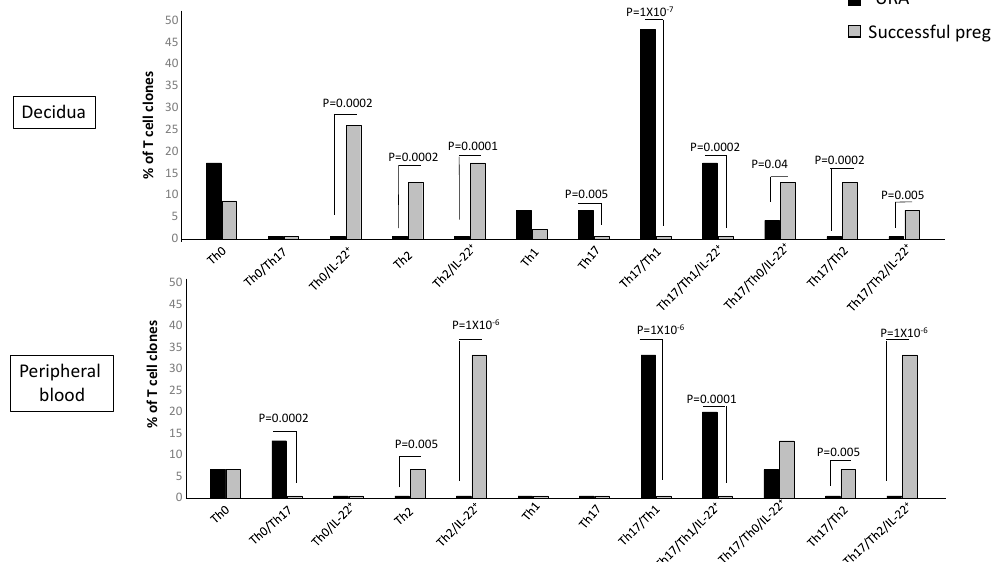
Figure 5. T helper subpopulations present in the decidua and in the peripheral blood of those T helper subpopulations present in the decidua and in the peripheral blood of experiencing unexplained recurrent abortion and those experiencing successful pregnancy. To those experiencing unexplained recurrent abortion and those experiencing successful investigate the CD4+ cell subsets that produce IL-22, the percentages of Th1-, Th2-, Th0-, Th17-, Th17/Th1-, Th17/Th2-, and Th17/Th0 cells, which do not produce IL-22 and which also produce IL-22 (Th1/IL-22+, Th2/IL-22+, Th0/IL-22+, Th17/IL-22+, Th17/Th1/IL-22+, Th17/Th2/IL-22+, and Th17/Th0/IL-22+) were analyzed. Cytokines were measured in the supernatants of the CD4+ T cell clones derived from the decidua and peripheral blood of those experiencing successful pregnancy and those experiencing unexplained recurrent abortion (URA) (Experiment 1 in section 4.3) by a multiplex bead-based assay. The statistical analysis was performed with the chi-square test.